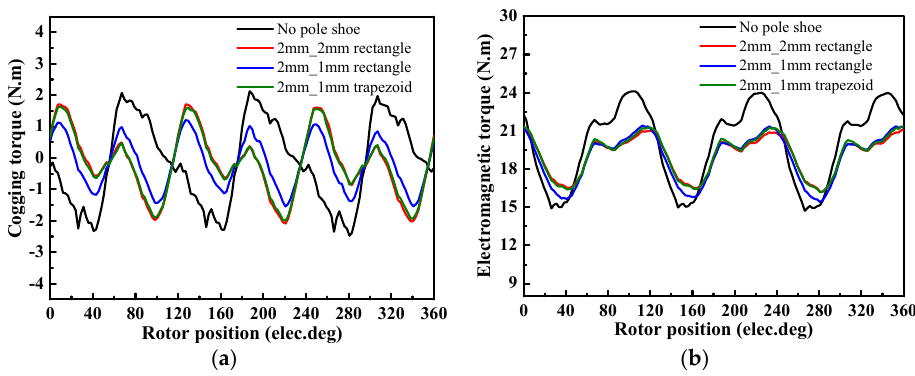
Figure 8. Cogging torque and electromagnetic torque: ( a ) Cogging torque of 12S/10P MSOR-FSPM motor; ( b ) Electromagnetic torque of 12S/10P MSOR-FSPM motor.